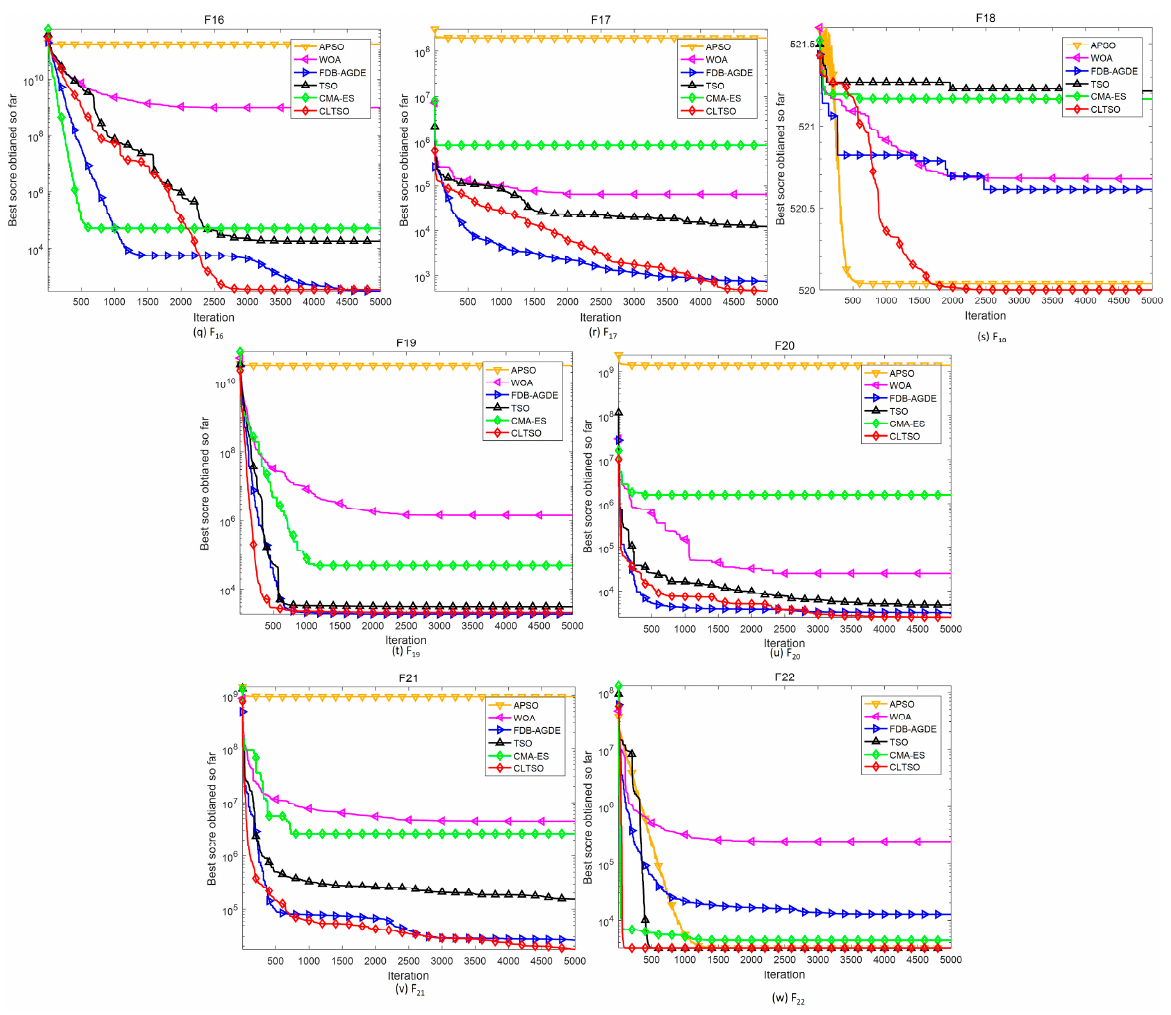
Figure 7. Convergence curve of each algorithm.